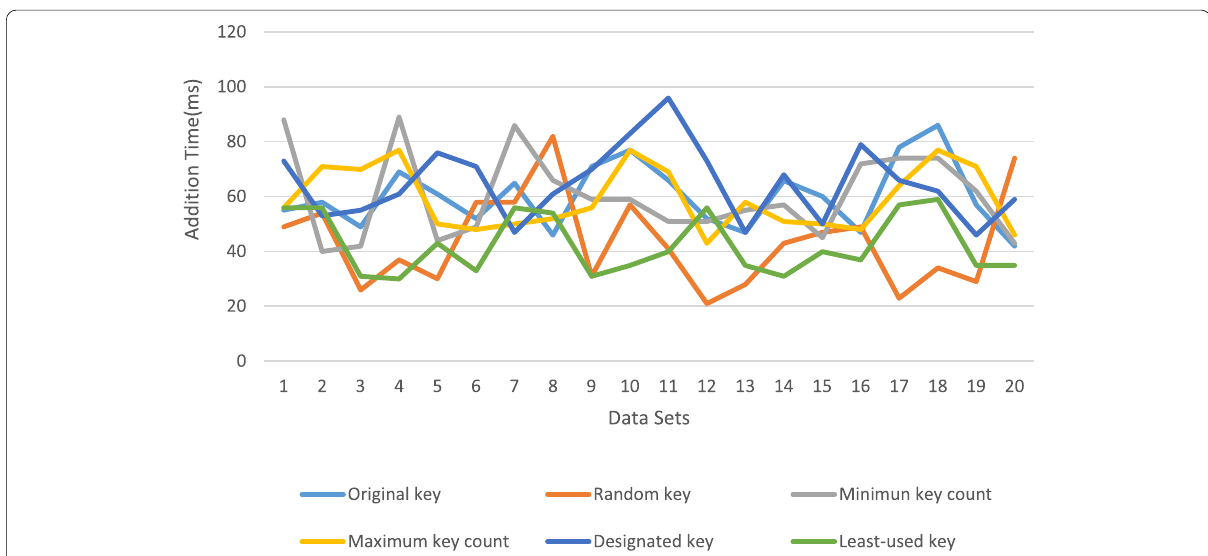
Fig. 14 Addition time on primary index models generated using the six key selection methods with unequal appearing probabilities of parameters in service retrieval requests